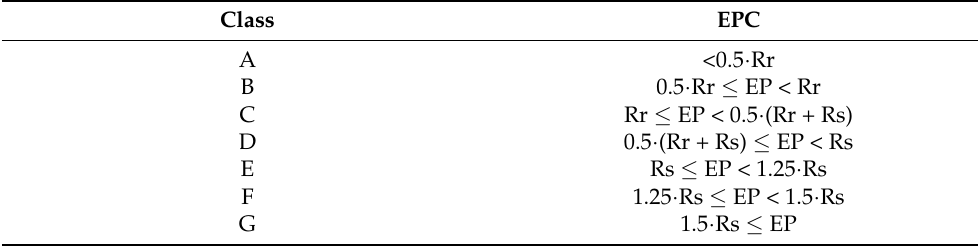
Table 4. Rules for determining the performance classes, Method 1